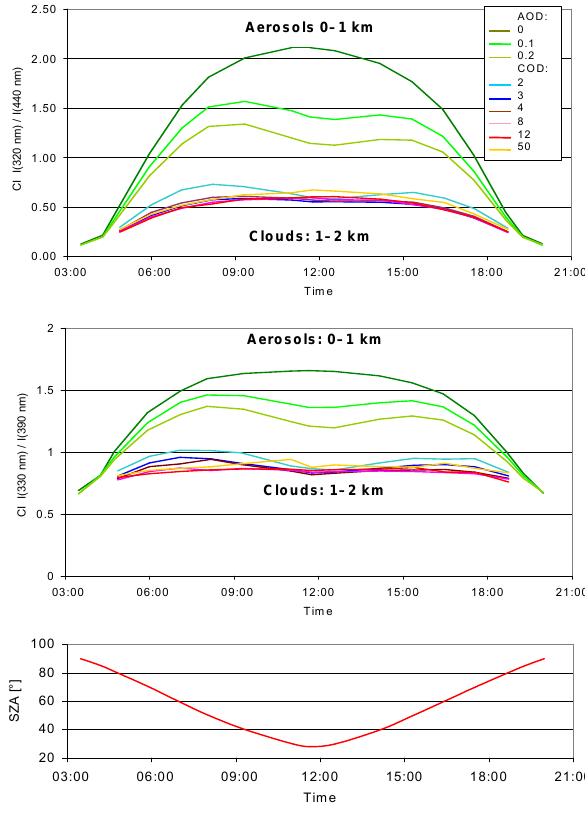
Figure 1. Simulated colour indices for an elevation an- gle of 85 ◦ (top: CI original = 320nm/440nm; middle: CI new = 330nm/390nm) for different aerosol and cloud opti- cal depths. For the aerosol cases (green lines) the OD represents the value at 390nm (Ångström exponent = 1); for the cloud cases (OD ≥ 2) the same optical depth is assumed for both wavelengths (Ångström exponent = 0). The aerosol layer is between the surface and 1km; the cloud layer is between 1 and 2km. Aerosol properties are described by a Henyey–Greenstein model with an asymmetry parameter of 0.68 and a single scattering albedo of 0.95. Bottom: SZA for a day (26 June 2009) in the middle of the